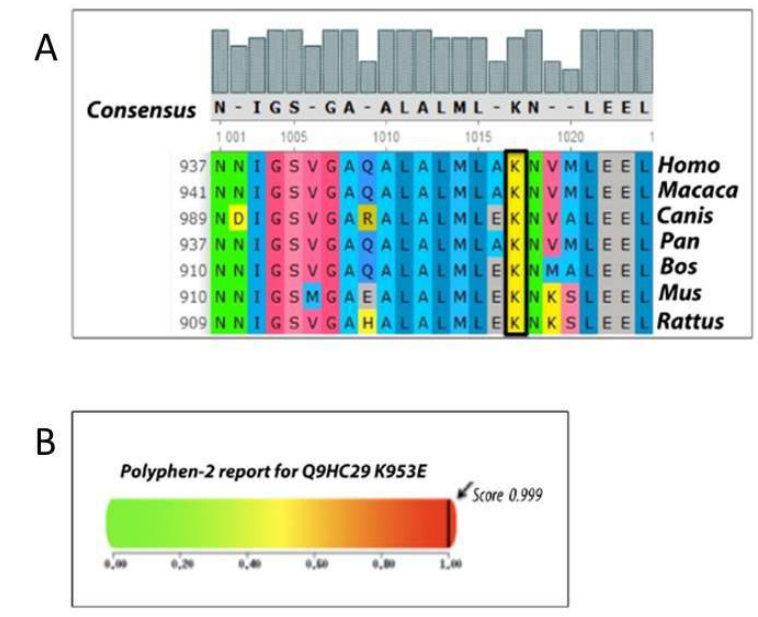
Figure 2. Bioinformatics analysis results. ( A ) Multiple alignment of the amino acid sequence of NOD2 protein in seven species showed that this is a conserved region; ( B ) PolyPhen2 (Polymorphism Phenotyping v.2) analysis predicting the probably damaging impact of the K953E substitution with a score of